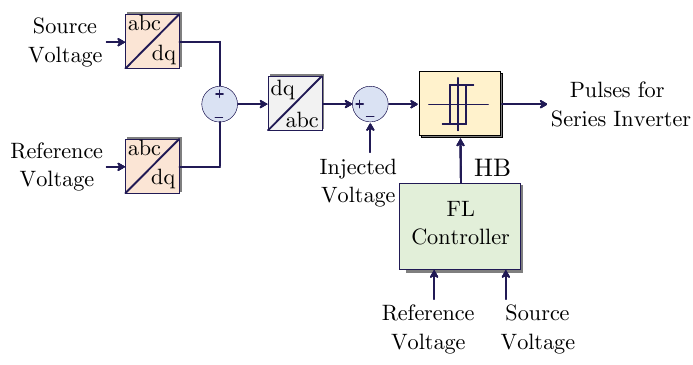
Figure 3. Control diagram of the series active